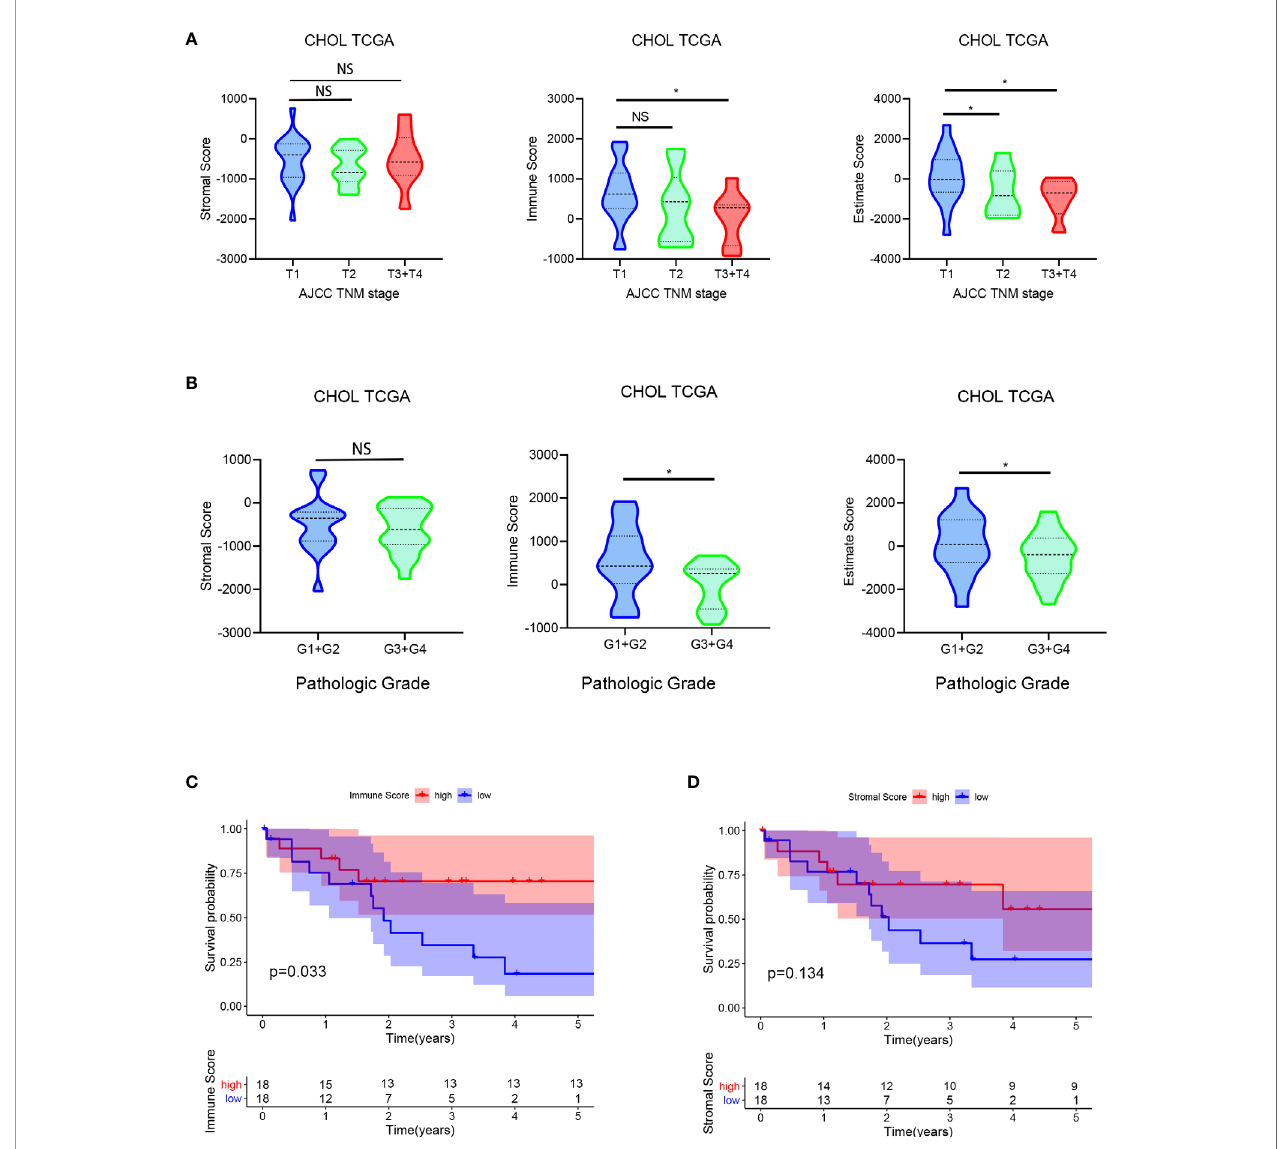
FIGURE 1 | Evaluating immune/stromal scores in cholangiocarcinoma tissues. The obtained CCA RNA-seq pro fi les were calculated by the ESTIMATE algorithm for immune scores and stromal scores. Then we analyzed the correlation between the immune/stromal scores and clinical characteristics (TNM stage and pathologic grade) (A, B) . In addition, based on immune/stromal scores, we divided the CCA patients into high- and low-score groups to investigate the relationship between overall survival and immune/stromal scores (C, D) . * P <